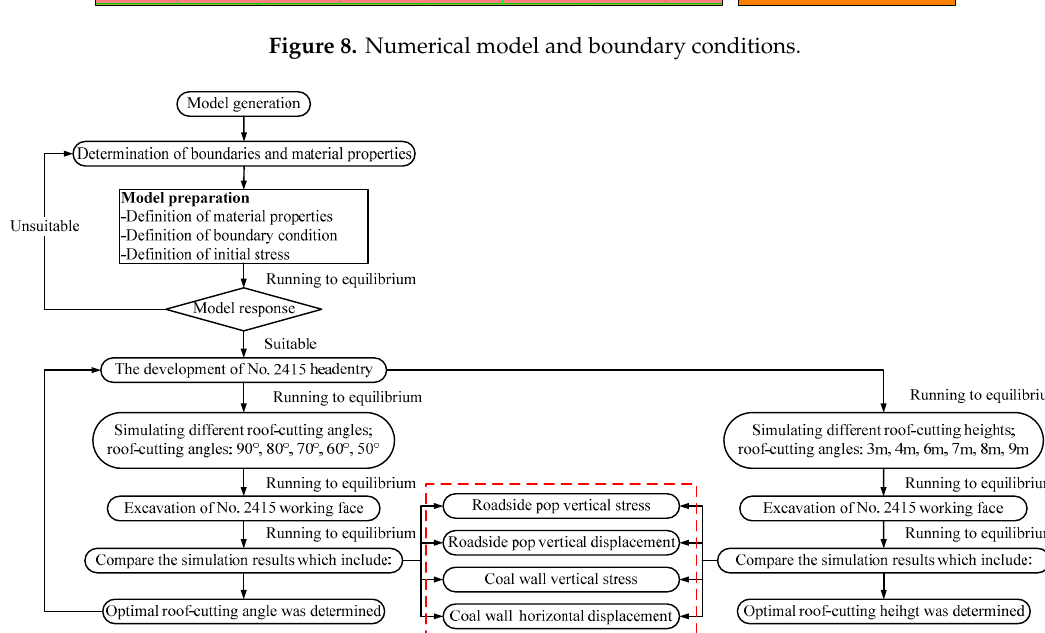
Figure 9. Flowchart of numerical modeling for optimal roof cutting parameters.